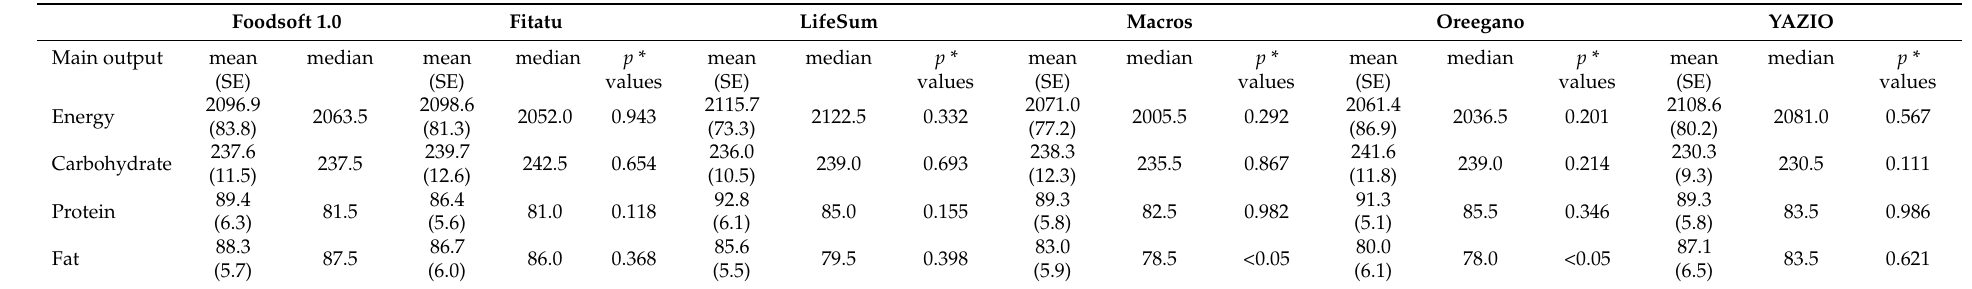
Table 3. Mean, standard error of mean (SE) and median of energy and nutrient intake estimated by Foodsoft 1.0 and the five apps for the whole 24-HRs.